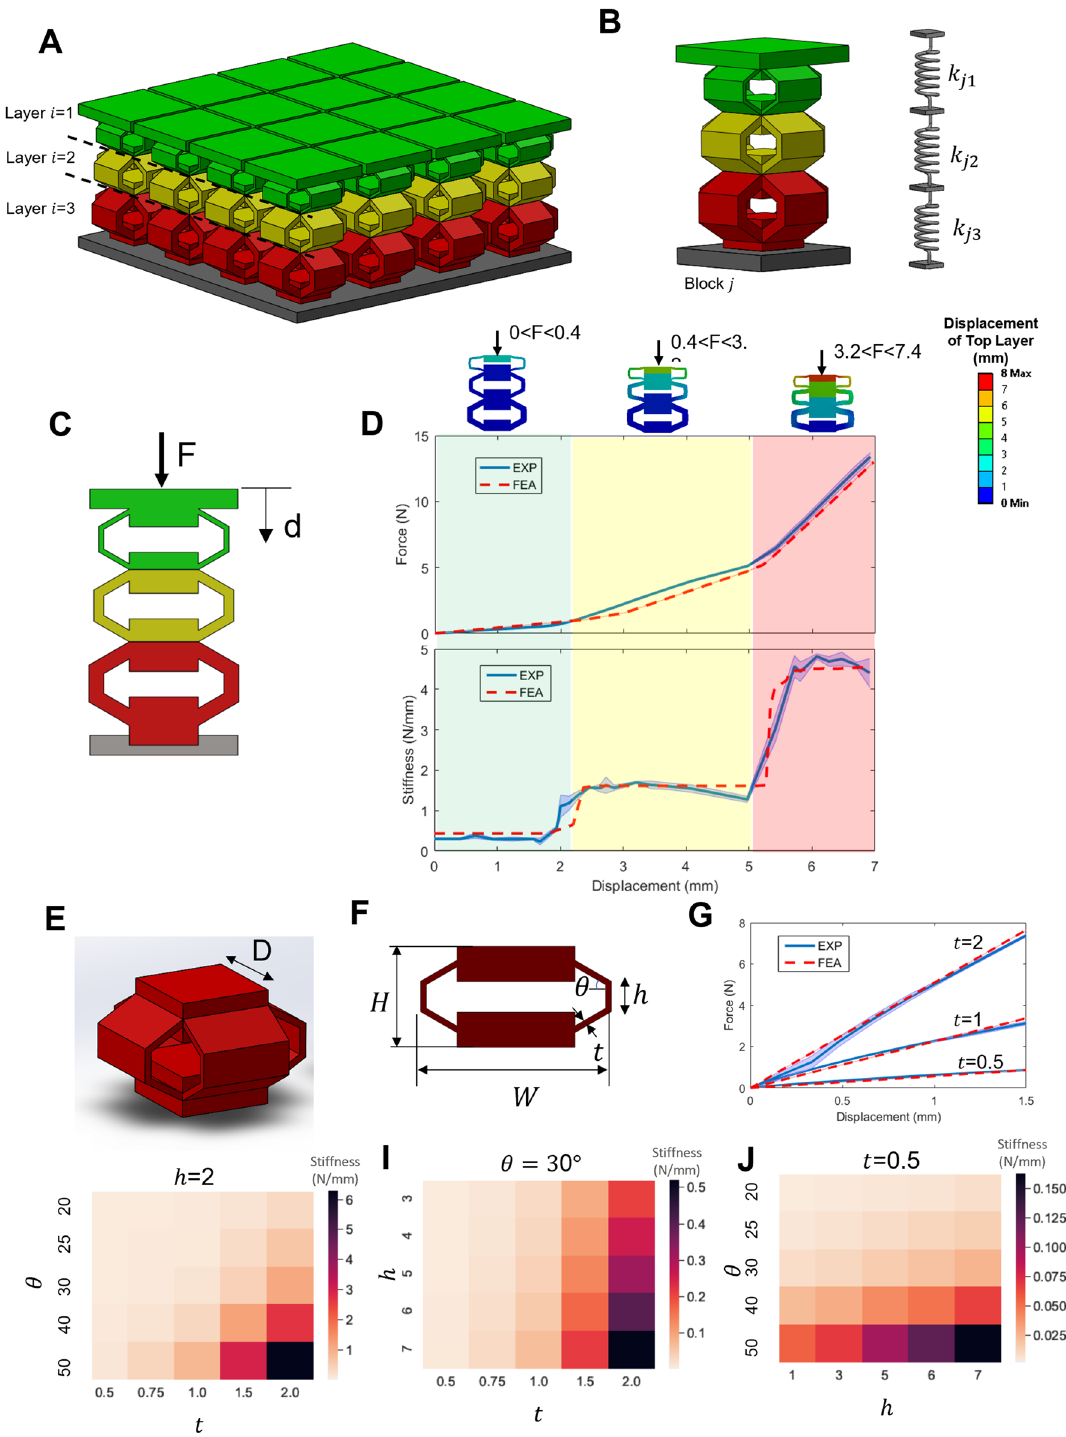
Figure 1. Mechanical metamaterial structure of the MST sensor force transfer medium. ( A ) Schematic of the MST sensor structure with an array of multi-layered blocks. ( B ) A single block schematic and its spring model analogous. ( C ) The cross-section of a single block with three layers. ( D ) Force–displacement plot of a single nominal block and its corresponding stiffness values. ( E ) 3D model of a unit cell. ( F ) Tuning parameters of a single unit cell ( θ , t , h ) for a given geometrical dimension of the unit cell (Depth, D – Height, H – Width, W ). ( G ) FEA and experimental results of a unit cell stiffness for different t values ( H-J ) Heatmap representation of the FEA results of the nominal unit cell stiffness for different set of tuning